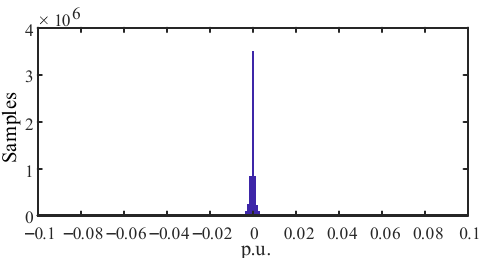
Figure 5. Histogram of measurement variation from January to October.